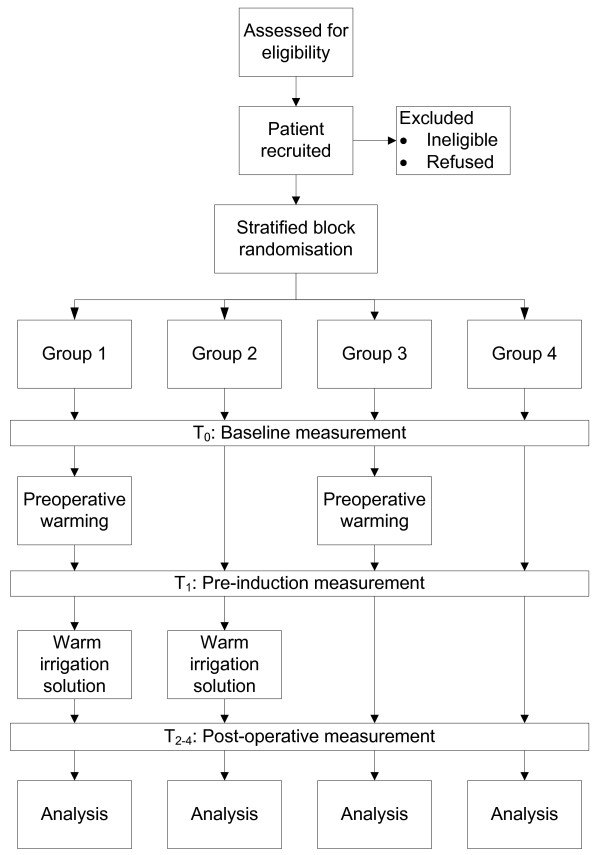
Study flow diagram.